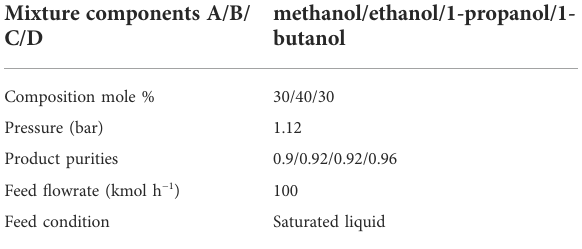
TABLE 10 Feed conditions for Example 4.